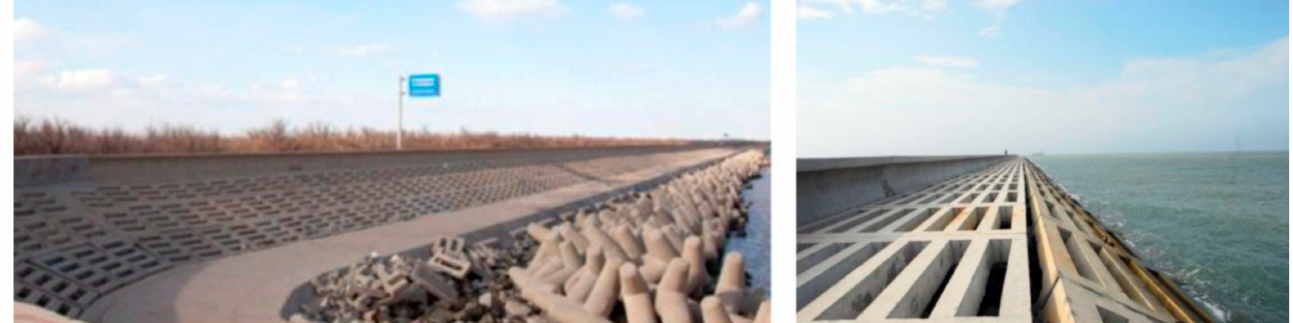
Figure 1. Photos of the built breakwater.